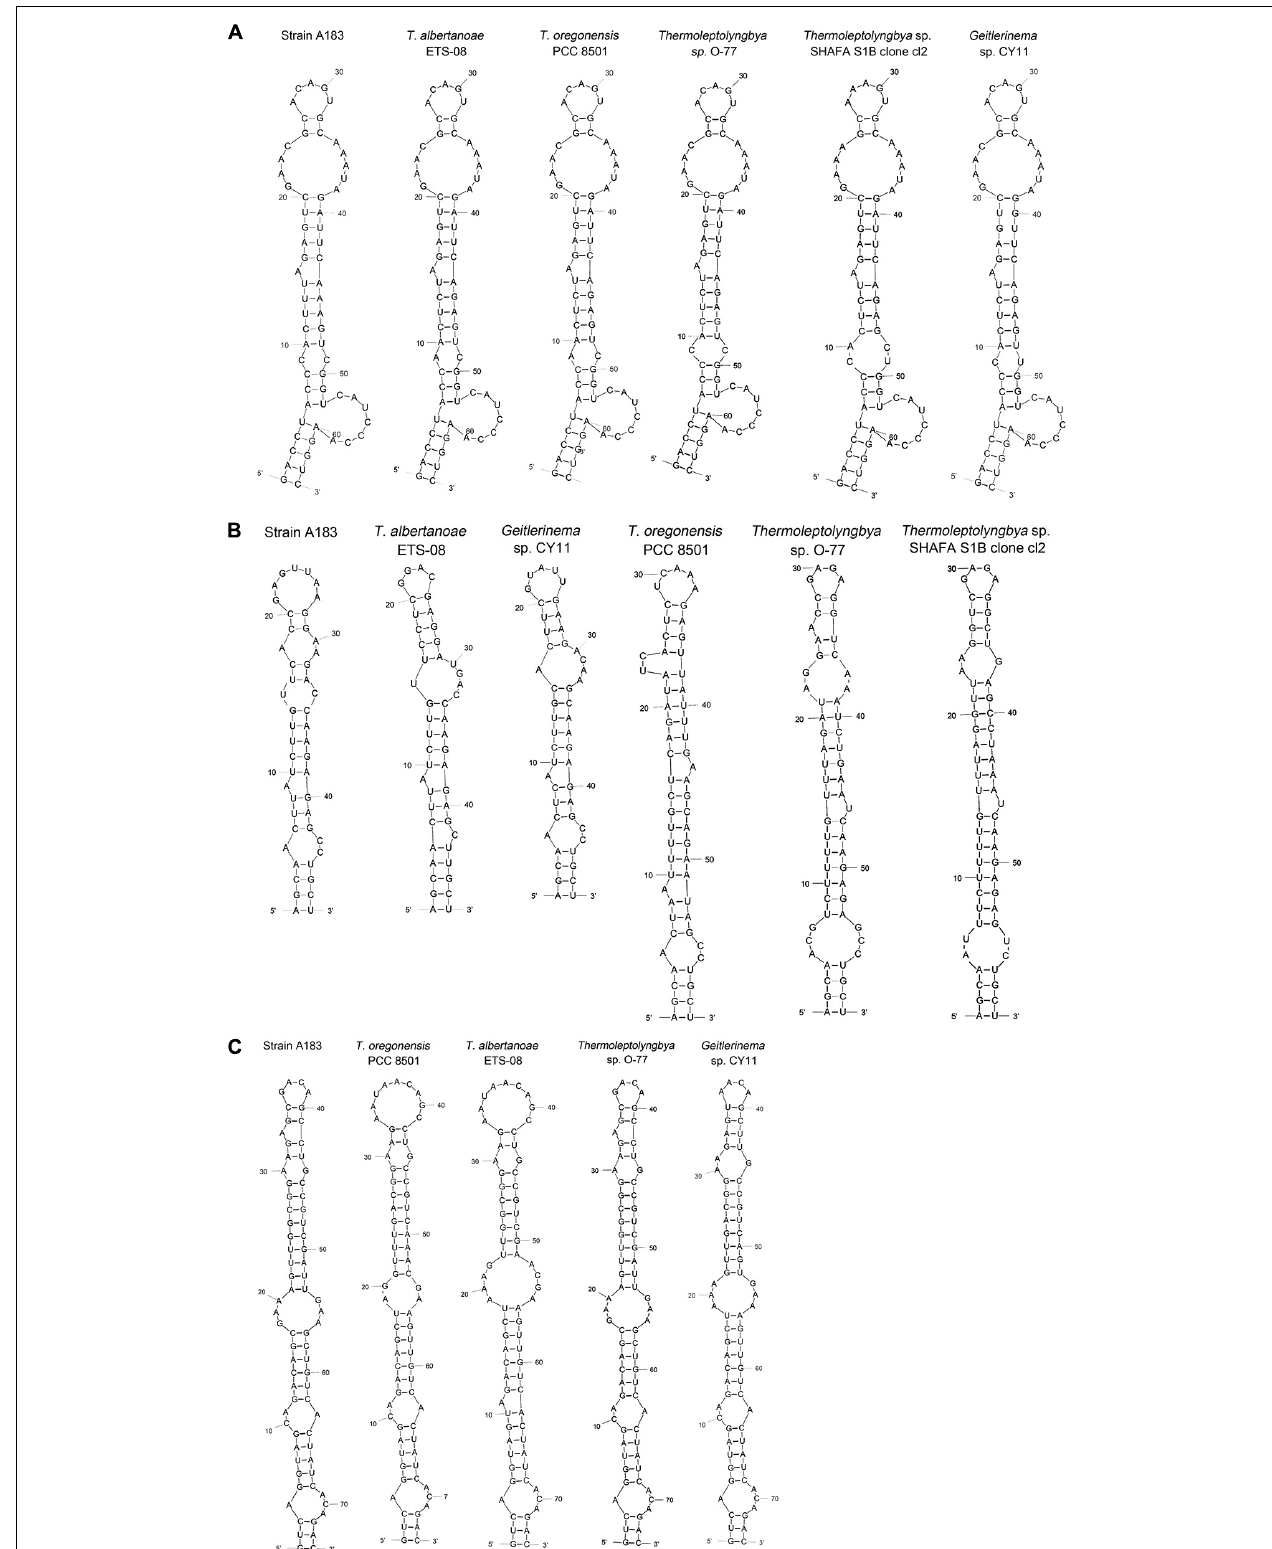
FIGURE 5 | Predicted secondary structures of D1-D1’ helix (A) , boxB (B) , and V3 helix (C) of 16S-23S ITS of Thermoleptolyngbya strains.